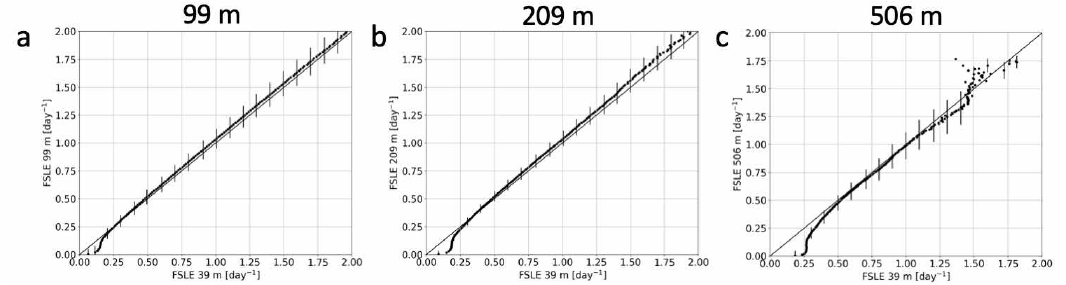
Figure 9. Scatterplot of FSLE filt at 39 m and FSLE filt at ( a ) 99 m, ( b ) 209 m, ( c ) 506 m from 27 October to 27 December 2011. The scatterplots are binned on the y -axis over 100 bins. FSLE filt at 39 m strongly correlate with FSLE filt at depth, highlighting the persistence of the vertical structure of the mesoscale strain field down to depths of 506 m. Thin vertical lines show std dev around the